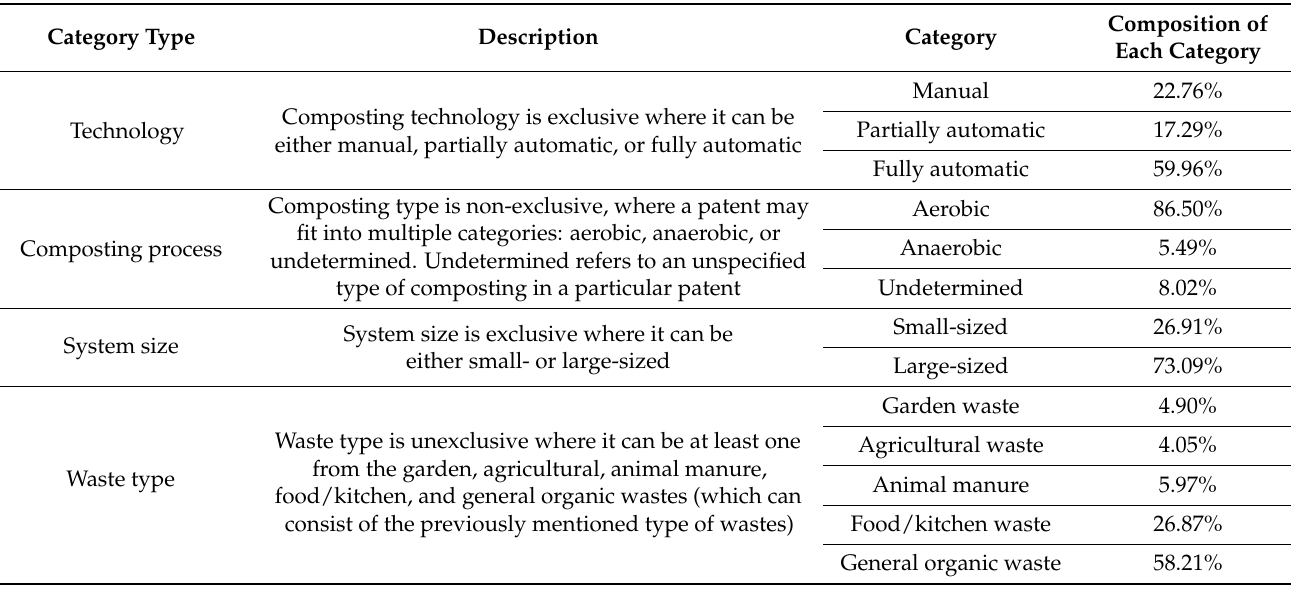
Table 7. Category type descriptions and composition of patents in each